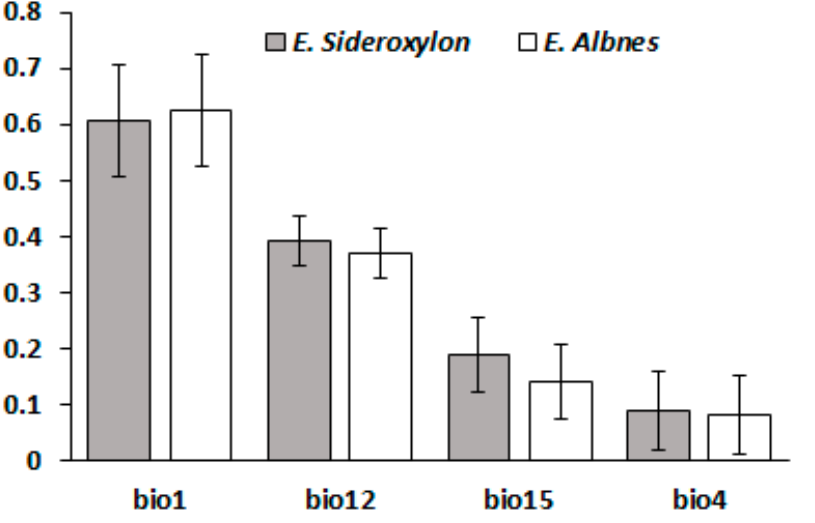
Figure 3. Variables contributions on response Eucalyptus sideroxylon and albens . bio1 (Annual Mean